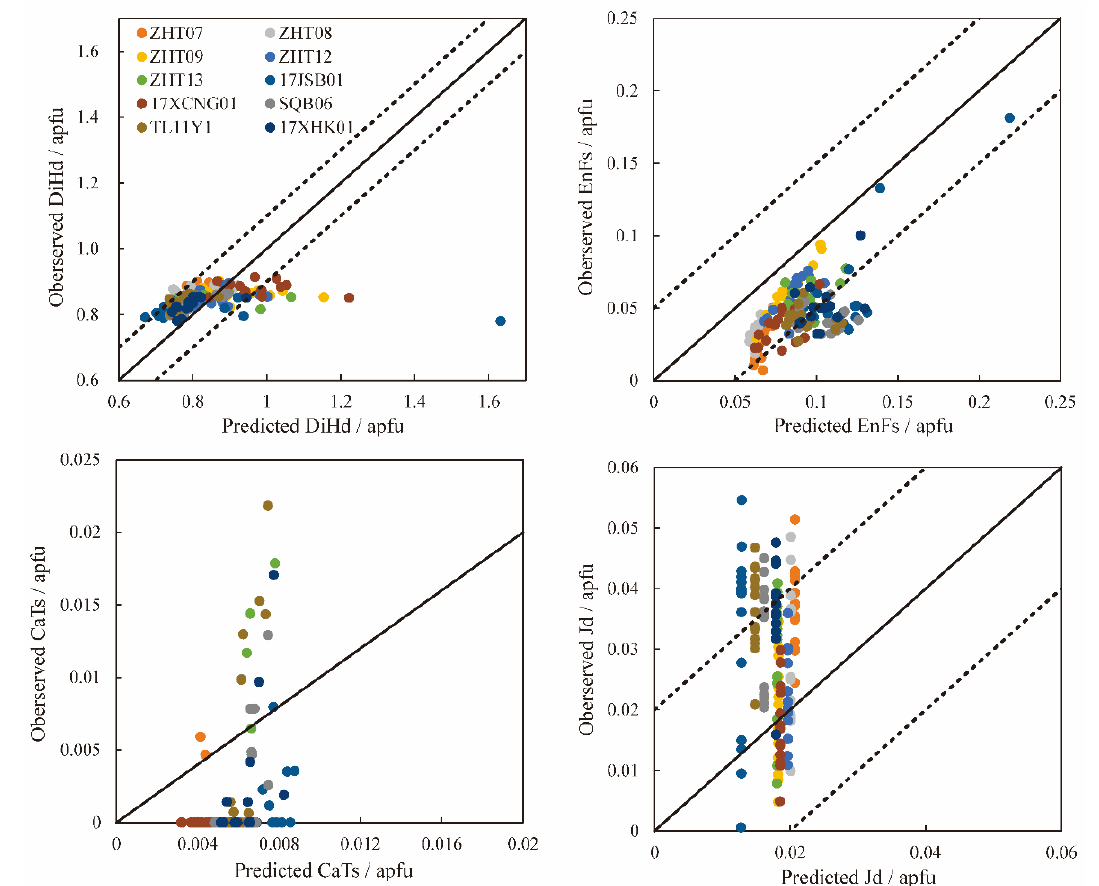
Figure A1. Clinopyroxene–melt equilibrium tests comparing measured and predicted DiHd, EnFs, CaTs and Jd. [14]. Dashed lines encompass the calibration errors of the models. The calibration error of DiHd is ±0.1 [107]. The solid line is the 1:1 line. The points outside the dashed line do not calculate the temperature and pressure.